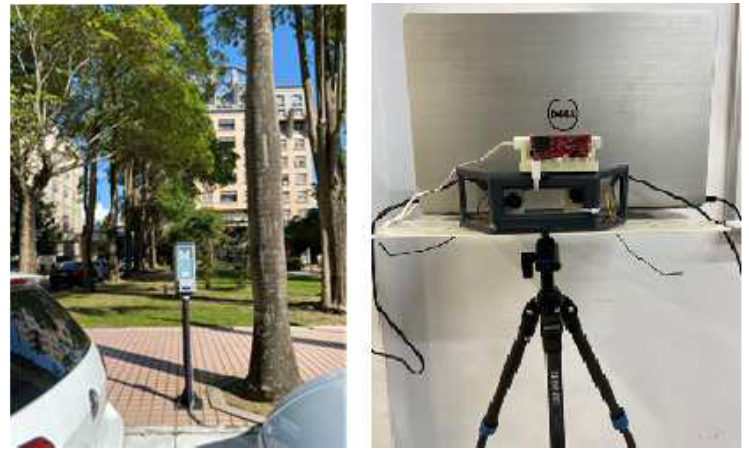
Figure 8. Parking meter data collector.